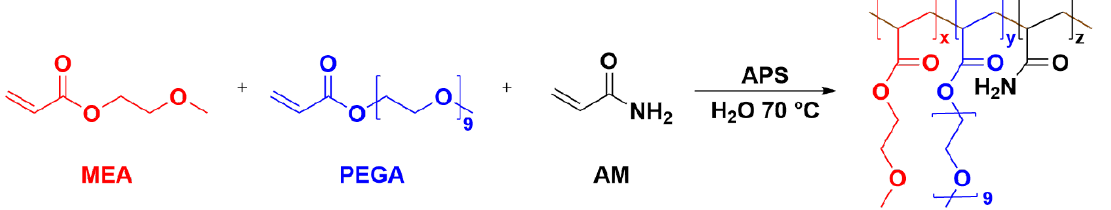
Figure 7. The synthesis of PEGA-MEA-AM multi-component gel. Red molecules represent the MEA fraction, blue molecules represent the PEGA fraction, and black molecules represent the AM frac- tion.